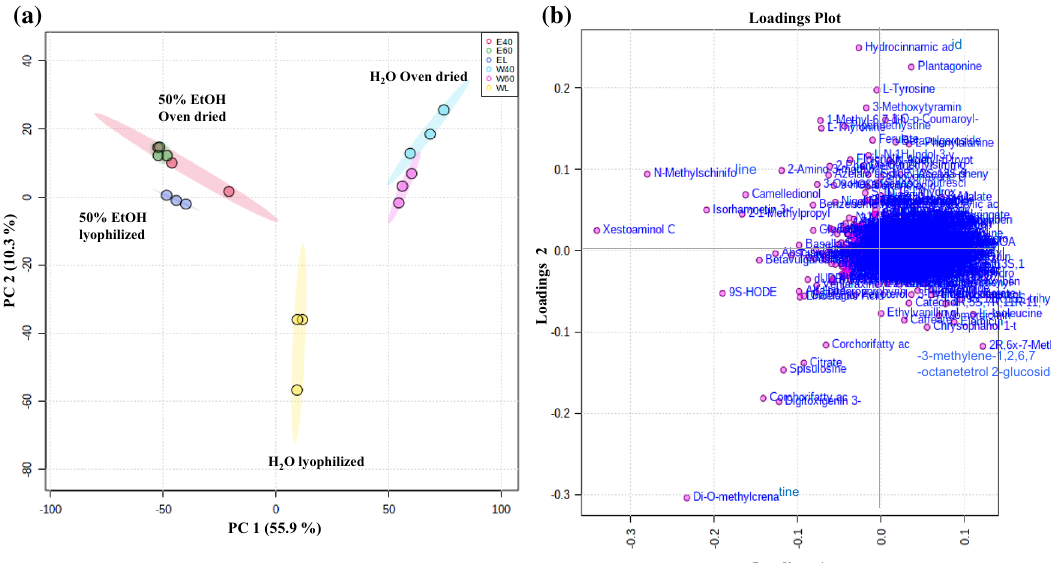
Figure 2. ( a ) PCA score plot derived from positive (ESI+) and negative (ESI−) mode in LC–MS metabolite profiles of A. macrostachyum water and 50% EtOH extracts ( b ) PCA loading plots for the selected PCs. Heatmap for the top 50 compounds identified based on PLSDA-VIP scores (distance measure using Euclidean, and clustering algorithm using ward) in water and 50% EtOH A. macrostachyum extracts A. macrostachyum extracts ( c ) Global features ( d ) Knowns only. WL: lyophilized water extract, W40: oven-dried water extract at 40 °C, W60: oven-dried water extract at 60 °C, EL: lyophilized 50% EtOH extract, E40: oven-dried 50% EtOH extract at 40 °C, E60: oven-dried 50% EtOH extract at 60 °C.